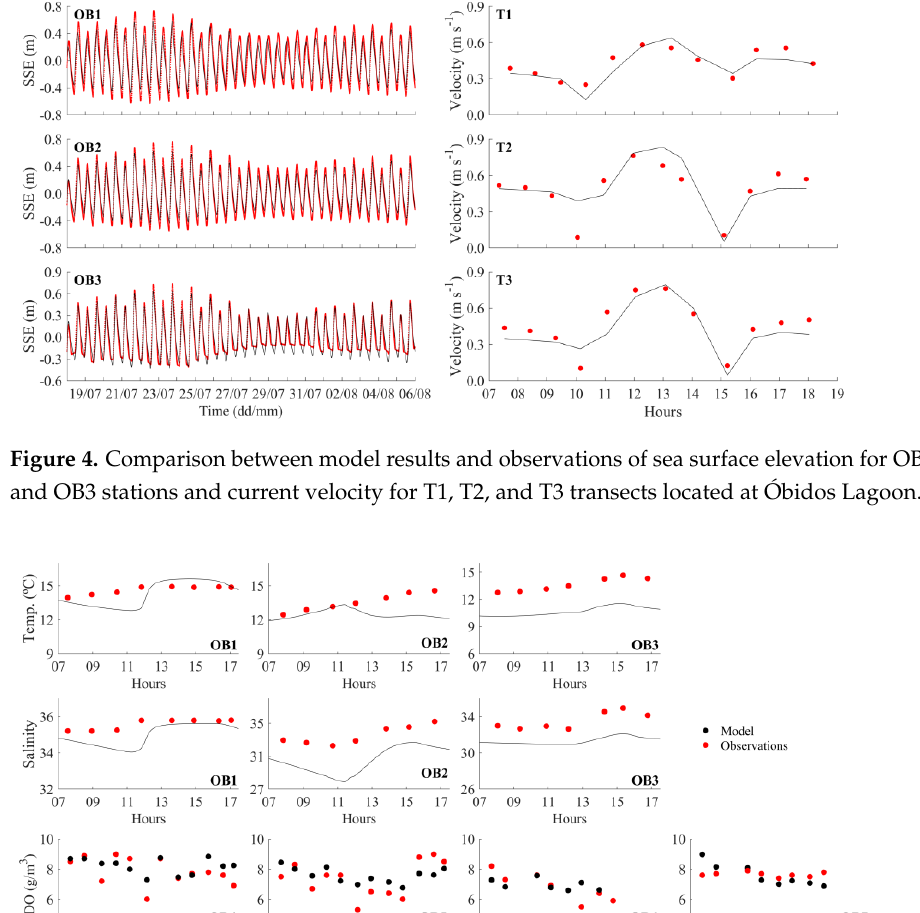
Figure 5. Comparison between model results and observations of water temperature, salinity, and dissolved oxygen concentration for stations OB1 to OB7 located at Ó bidos lagoon. Data concerning November and December months are missing for stations OB6 and OB7. Table 4. RMSE for Ó bidos Lagoon (OB1, OB2, OB3, OB4, OB5, OB6, OB7, OB8) stations.